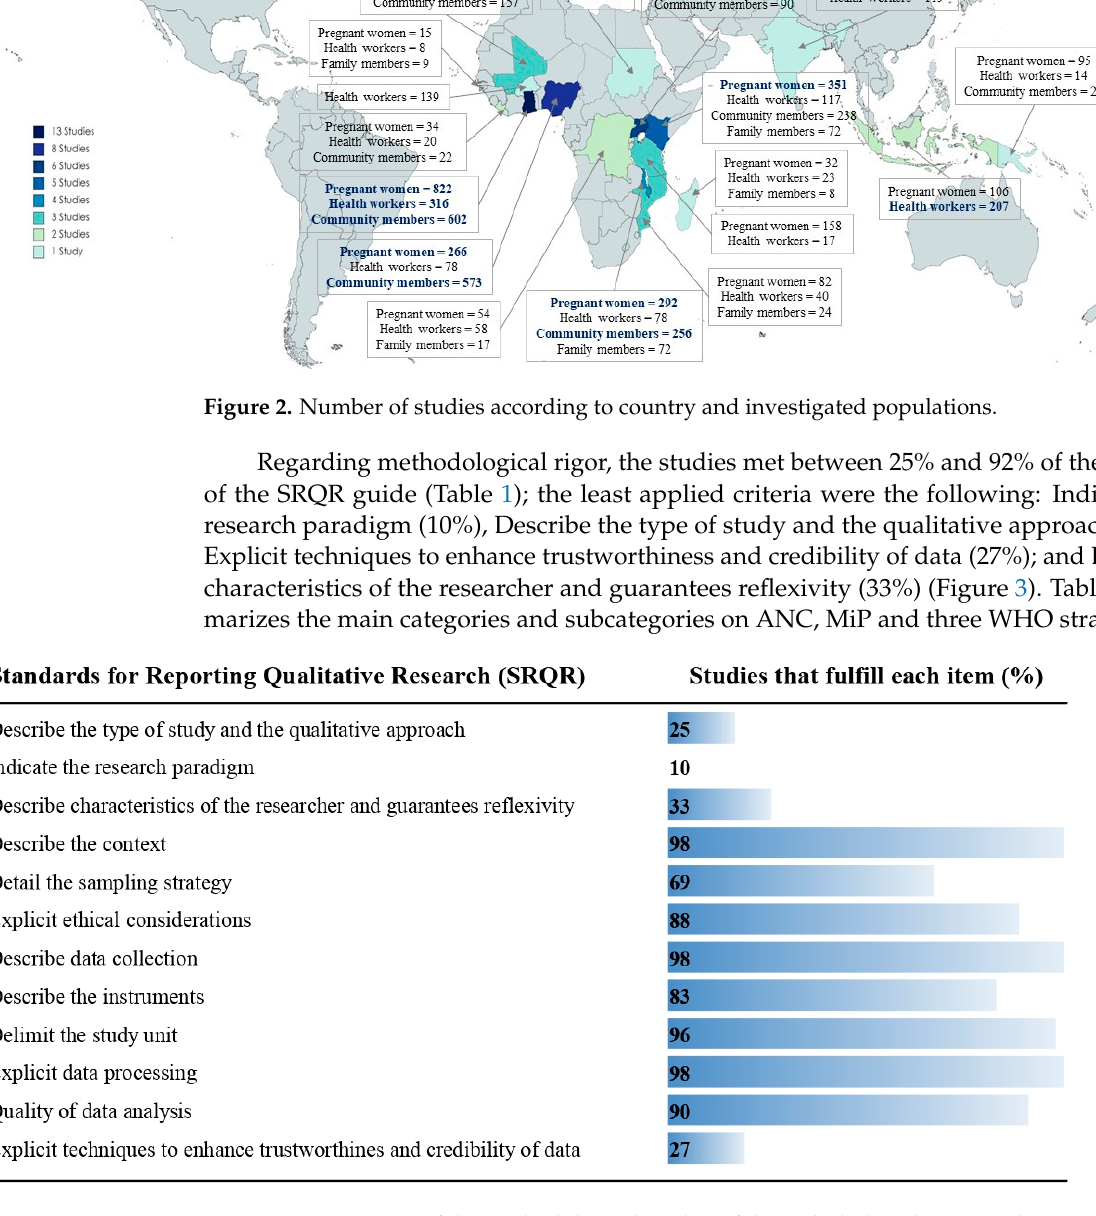
Figure 3. Assessment of the methodological quality of the included studies, according to Standards for Reporting Qualitative Research (SRQR) guide. Table 2. Categorial system according to the research topic.